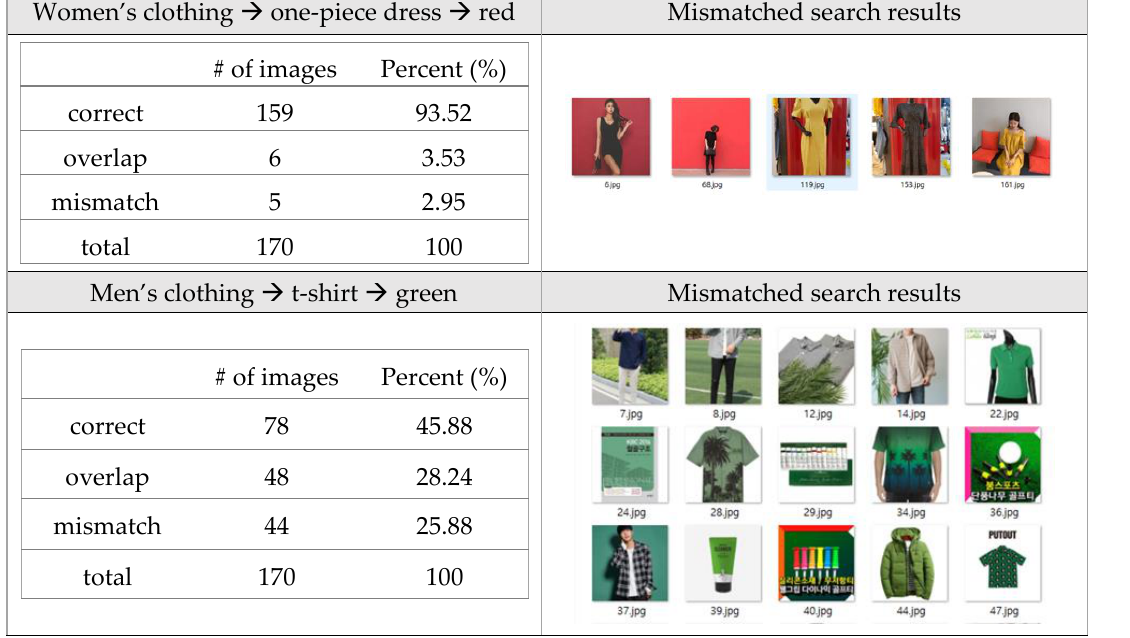
Figure 1. Preliminary study on fashion product retrieval. We searched for the products semi- Preliminary study on fashion product retrieval. We searched for the products automatically using the function provided by a major shopping mall. semi-automatically using the function provided by a major shopping